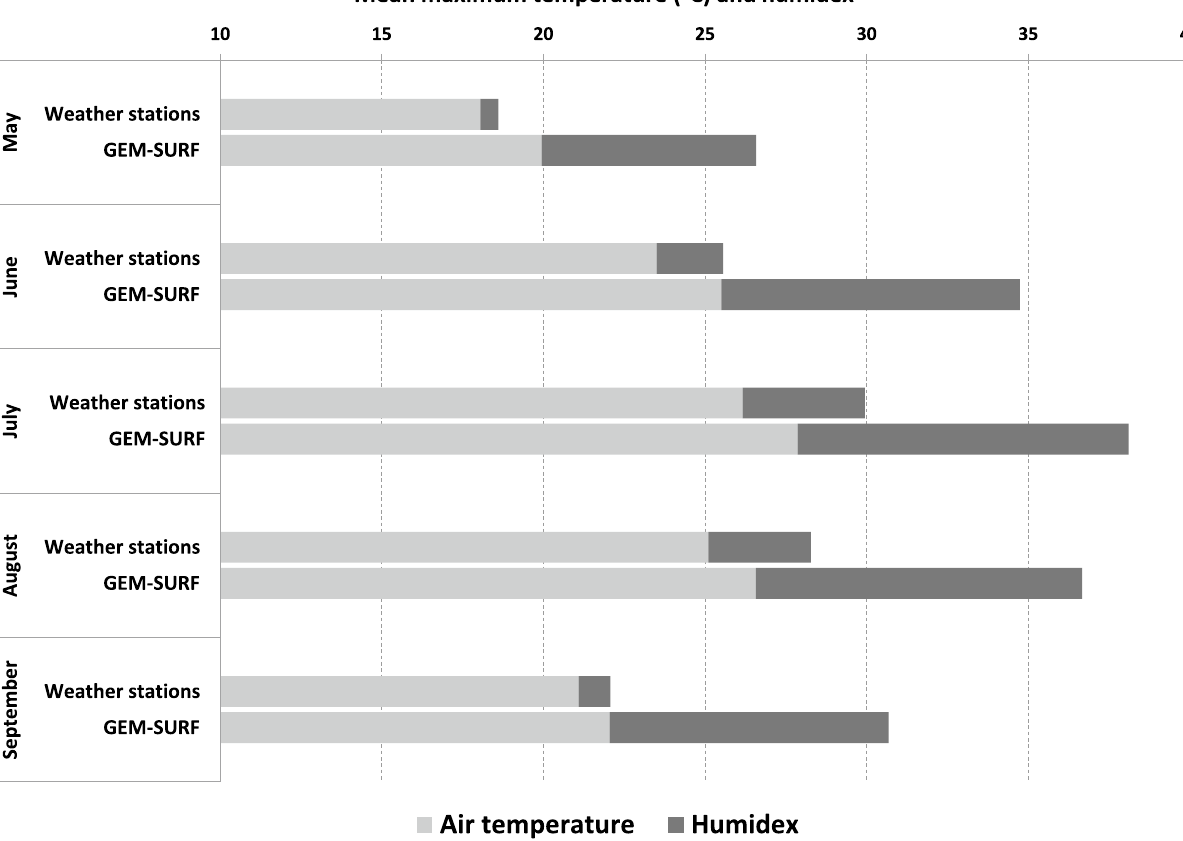
Figure 2. Comparison between mean maximum air temperature and humidex assigned by weather stations vs. GEM-SURF across urban Southwestern Ontario (May–September